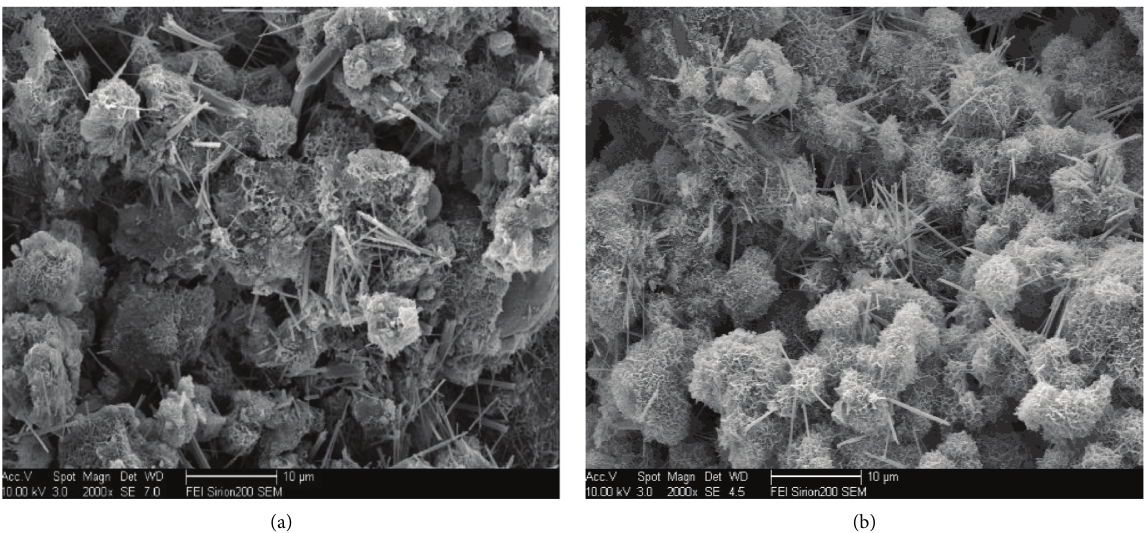
Figure 3: Scanning electron micrograph of fly ash filling body with (a) 3 days and (b) 5 days.